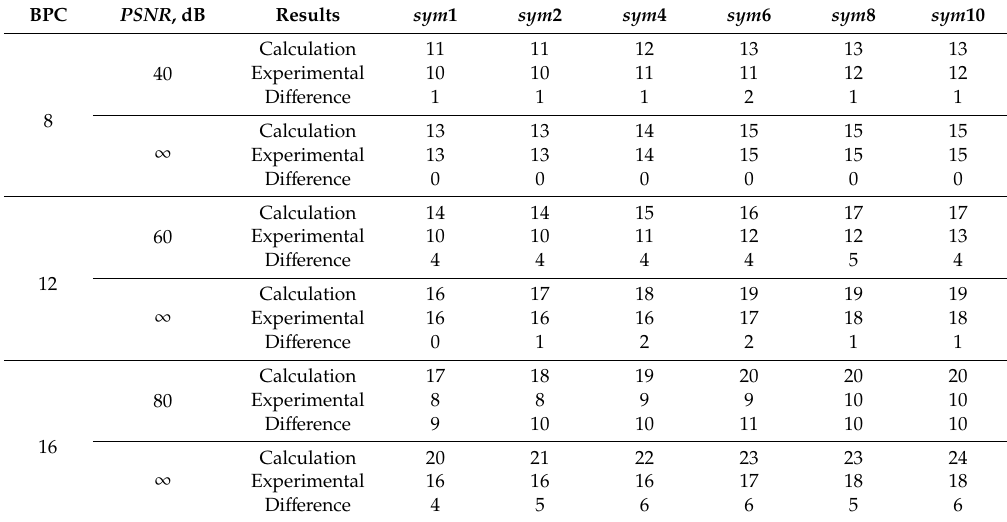
Table 32. Minimum values of r , at which the result of 3D tomographic images DWT by symlets reaches high and maximum quality.